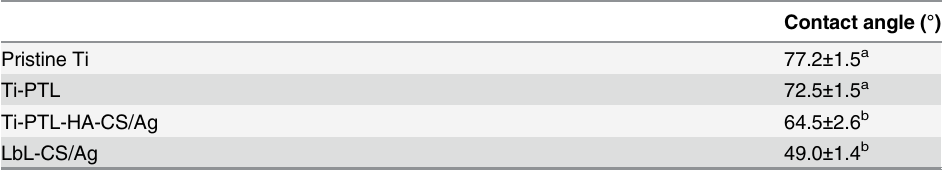
Table 2. Contact angle (mean ± SD) of the various